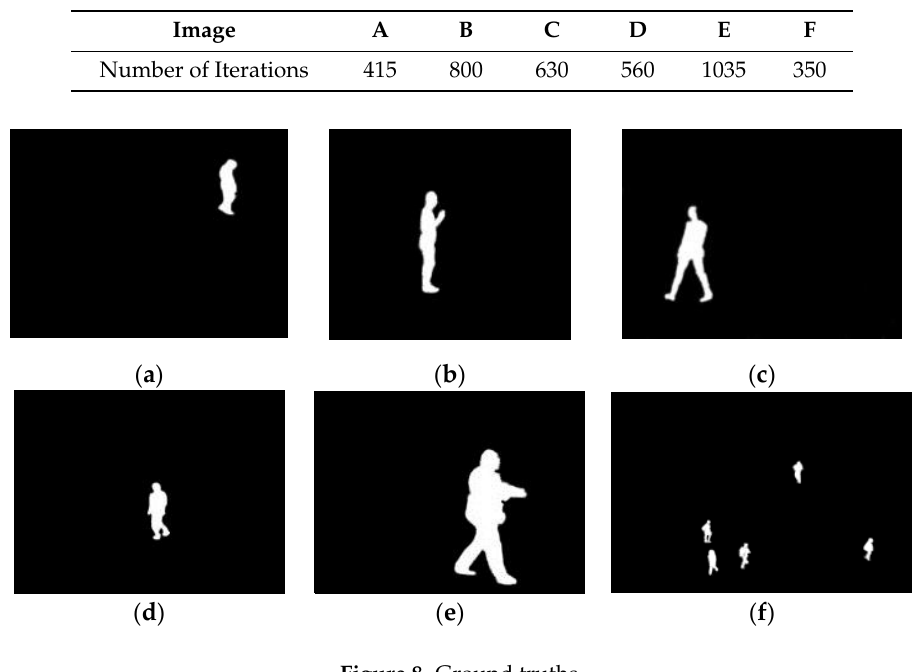
Figure 8. Ground truths.